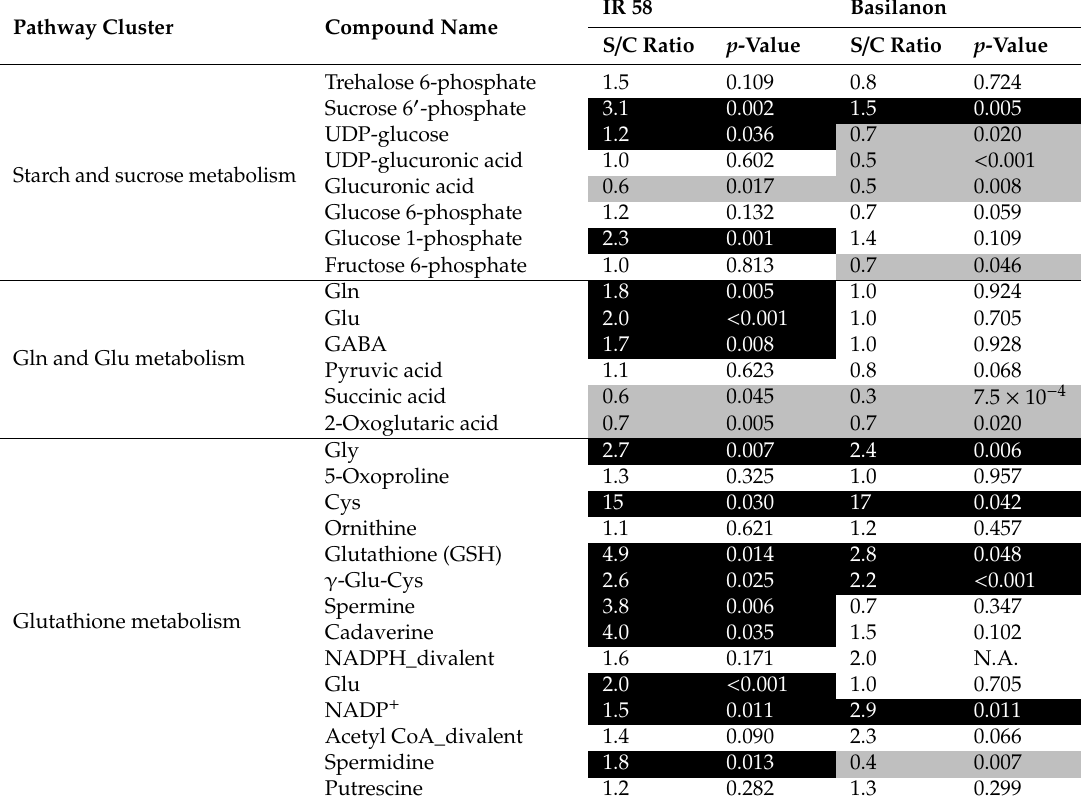
Table 3. E ff ect of osmotic stress on the root metabolites in a stress-tolerant rice cultivar (IR 58) and a stress-sensitive rice cultivar